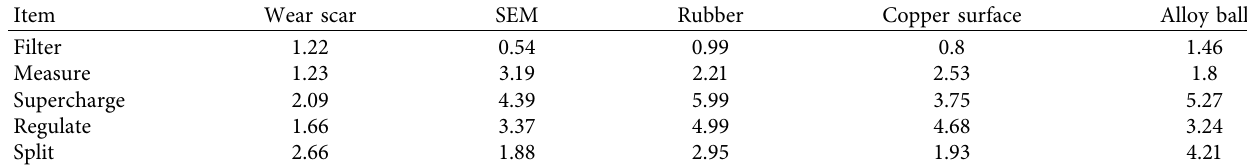
Figure 5: Wear scars on the brass plate of the frequency conversion constant pressure control system. Table 3: Carbide ball surface of the dual surface of the friction pair.